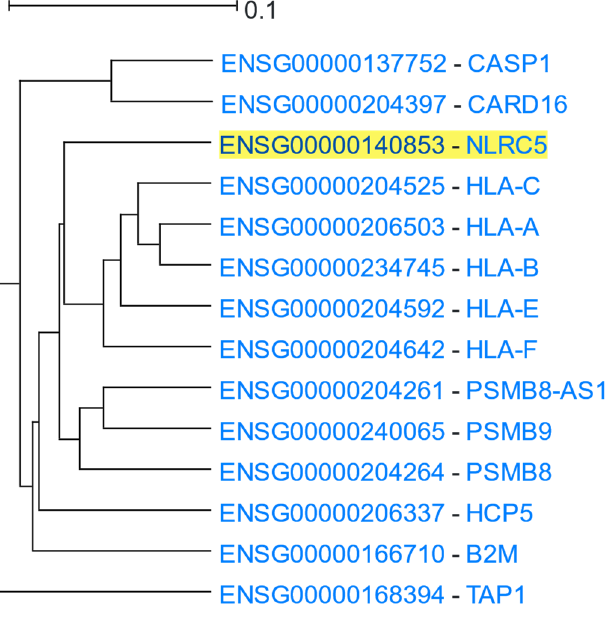
Figure 5. HGCA2.0 NLRC5 6 internal node coexpression clade. Table 4. Selected top gene term enrichments of the coexpressed genes to NLRC5 in HGCA2.0.